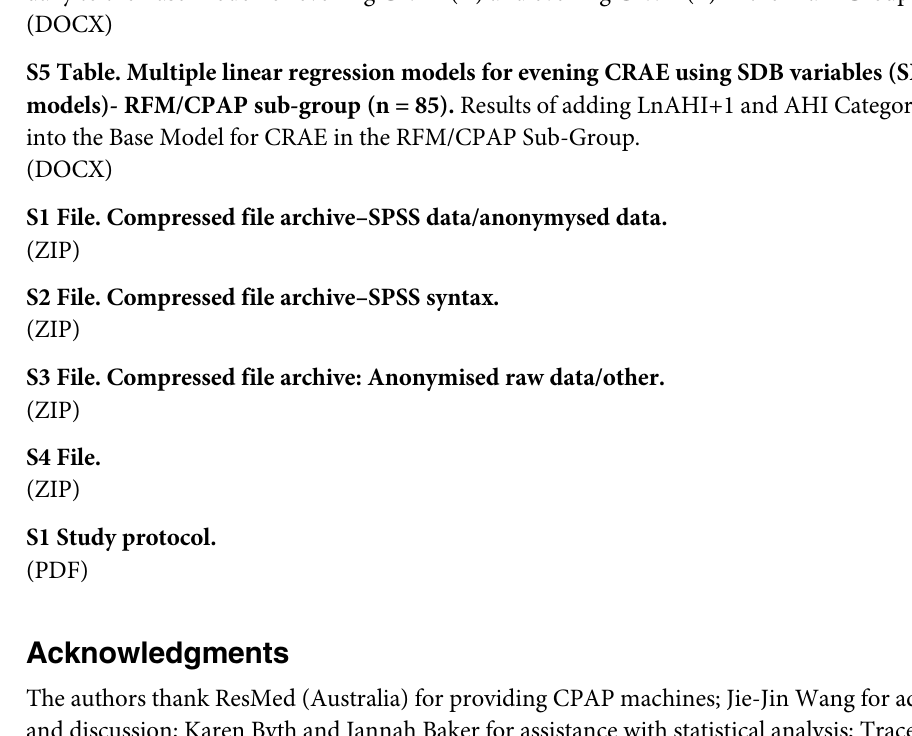
S3 Table. Multiple linear regression models for evening retinal vessel diameters using non -SDB variables (base models)—main group (n = 264). Base Models showing non- SDB vari- able predictors for evening CRAE (A) and evening CRVE (B) for the Main Group. S4 Table. Multiple linear regression models for evening retinal vessel diameters using SDB variables (SDB models)—main group (n = 264). Results of adding each SDB variable individ- ually to the Base Model for evening CRAE (A) and evening CRVE (B) in the Main Group. S5 Table. Multiple linear regression models for evening CRAE using SDB variables (SDB models)- RFM/CPAP sub-group (n = 85). Results of adding LnAHI+1 and AHI Category into the Base Model for CRAE in the RFM/CPAP